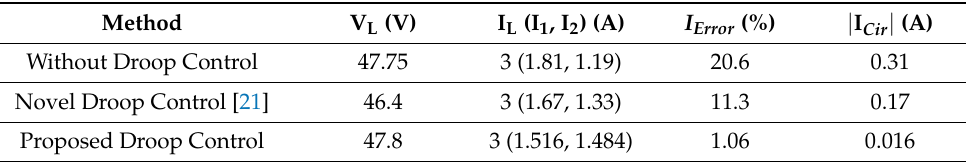
Table 7. Comparison of simulation results of different methods considering variation in load with different cable